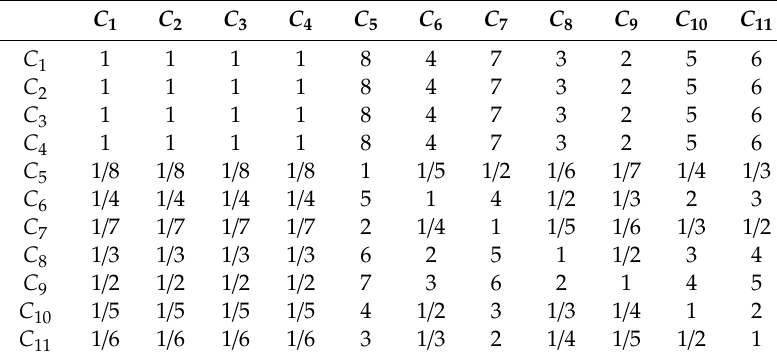
Table 8. Criteria Preference Matrix.